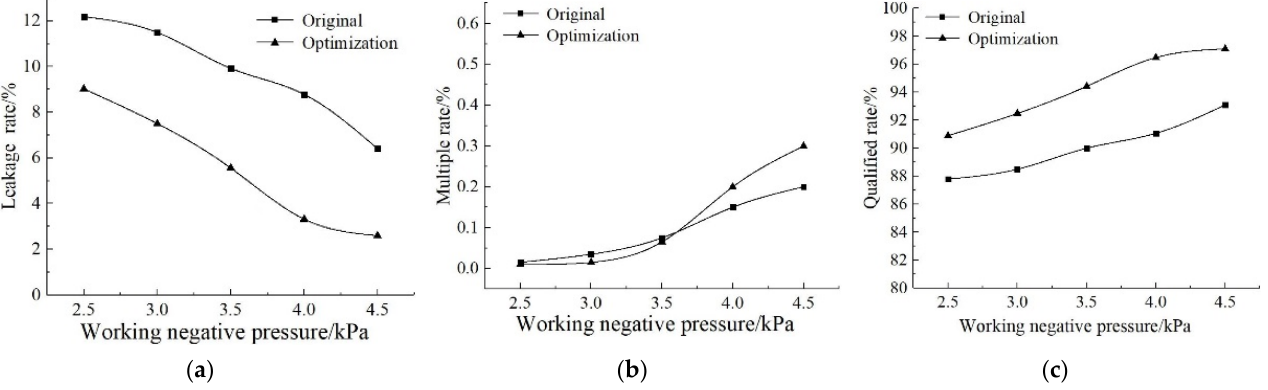
Figure 18. Comparison of the working performance of the seed metering device. ( a ) Lcakage rate; ( b ) Multiple rate; ( c ) Qualified rate.